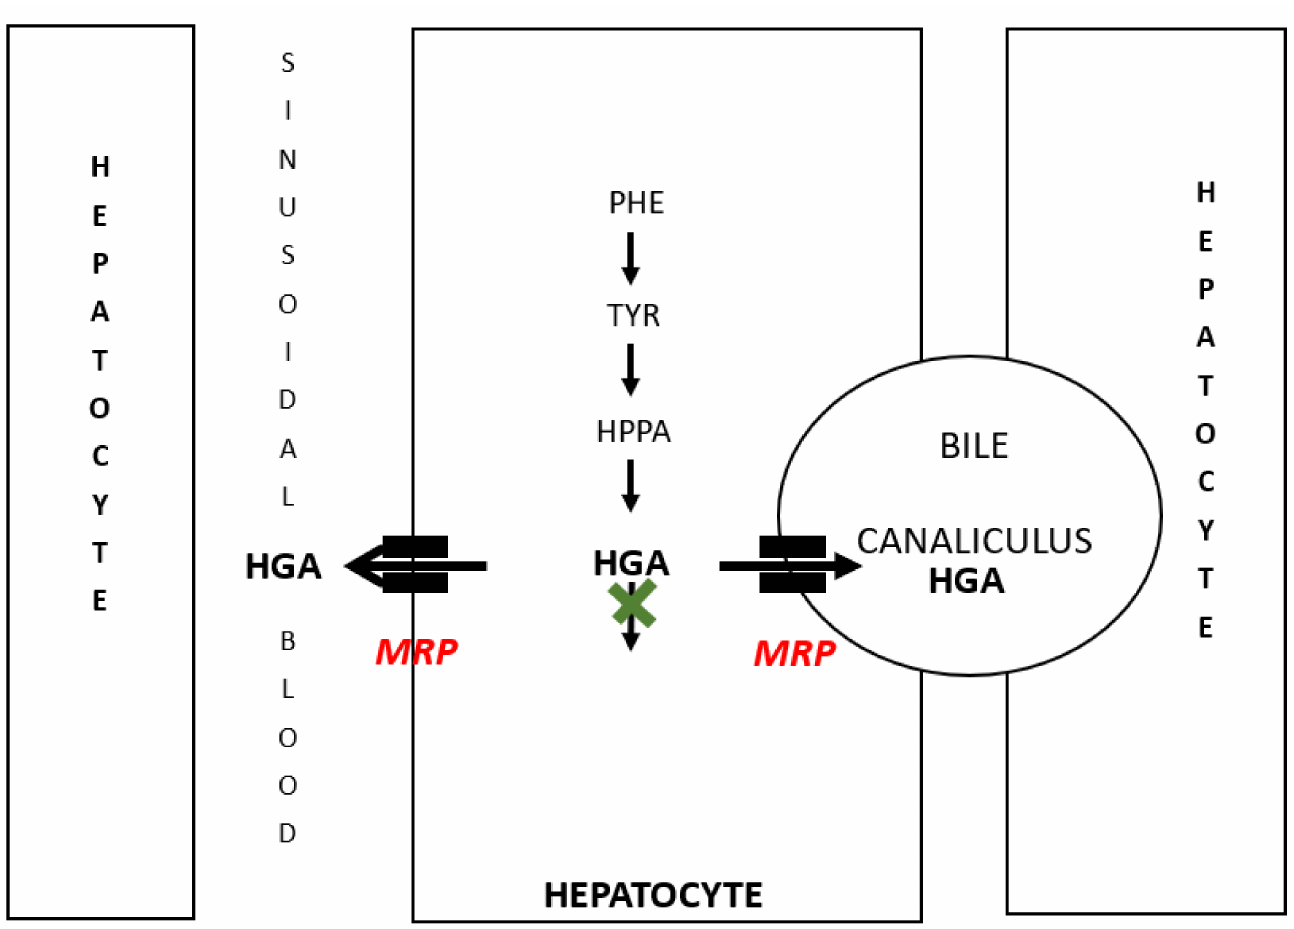
Figure 3. The cartoon depicts the handling of organic anion HGA in the hepatocyte. HGA accumu- lates due to lack of HGD enzyme (denoted by the green X). We propose that HGA can be eliminated via multidrug resistance-associated proteins (MRP, ABCC family of transporters) both into the biliary canaliculi as well as into the hepatic sinusoidal blood supported by the presence of these organic anion transporters at both these sites. HGA reaching the hepatic sinusoidal blood can be carried around the body before excretion by the kidney into the urine. PHE, TYR, HPPA and HGA represent phenylalanine, tyrosine, 4-hydroxyphenylpyruvate and